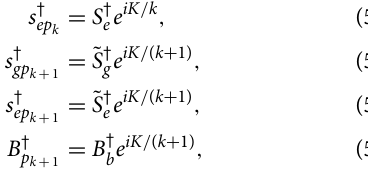
. The value of the of the selected operators are Bp 2 and Bp 3 B † p B † p 3 2 = = damping constant is γ B 0 . 0001 . The coupling constants are = g 1 g 2 0 . 1 = =